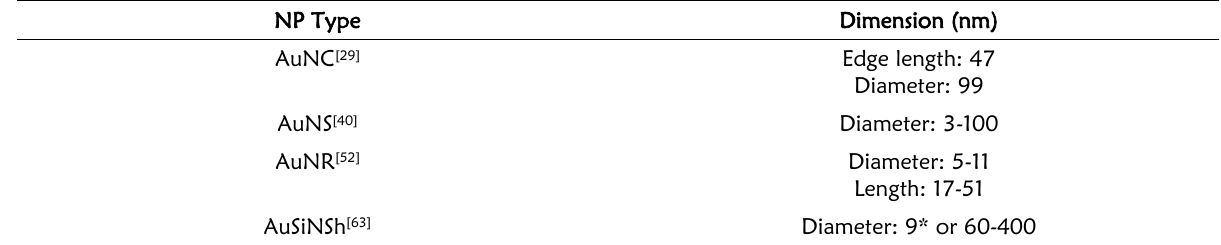
Table 5: Summary of typical particle sizes. Sources: [29, 40, 52, 63]. *9 nm diameter AuSiNShs have recently been formed using PLAL technology